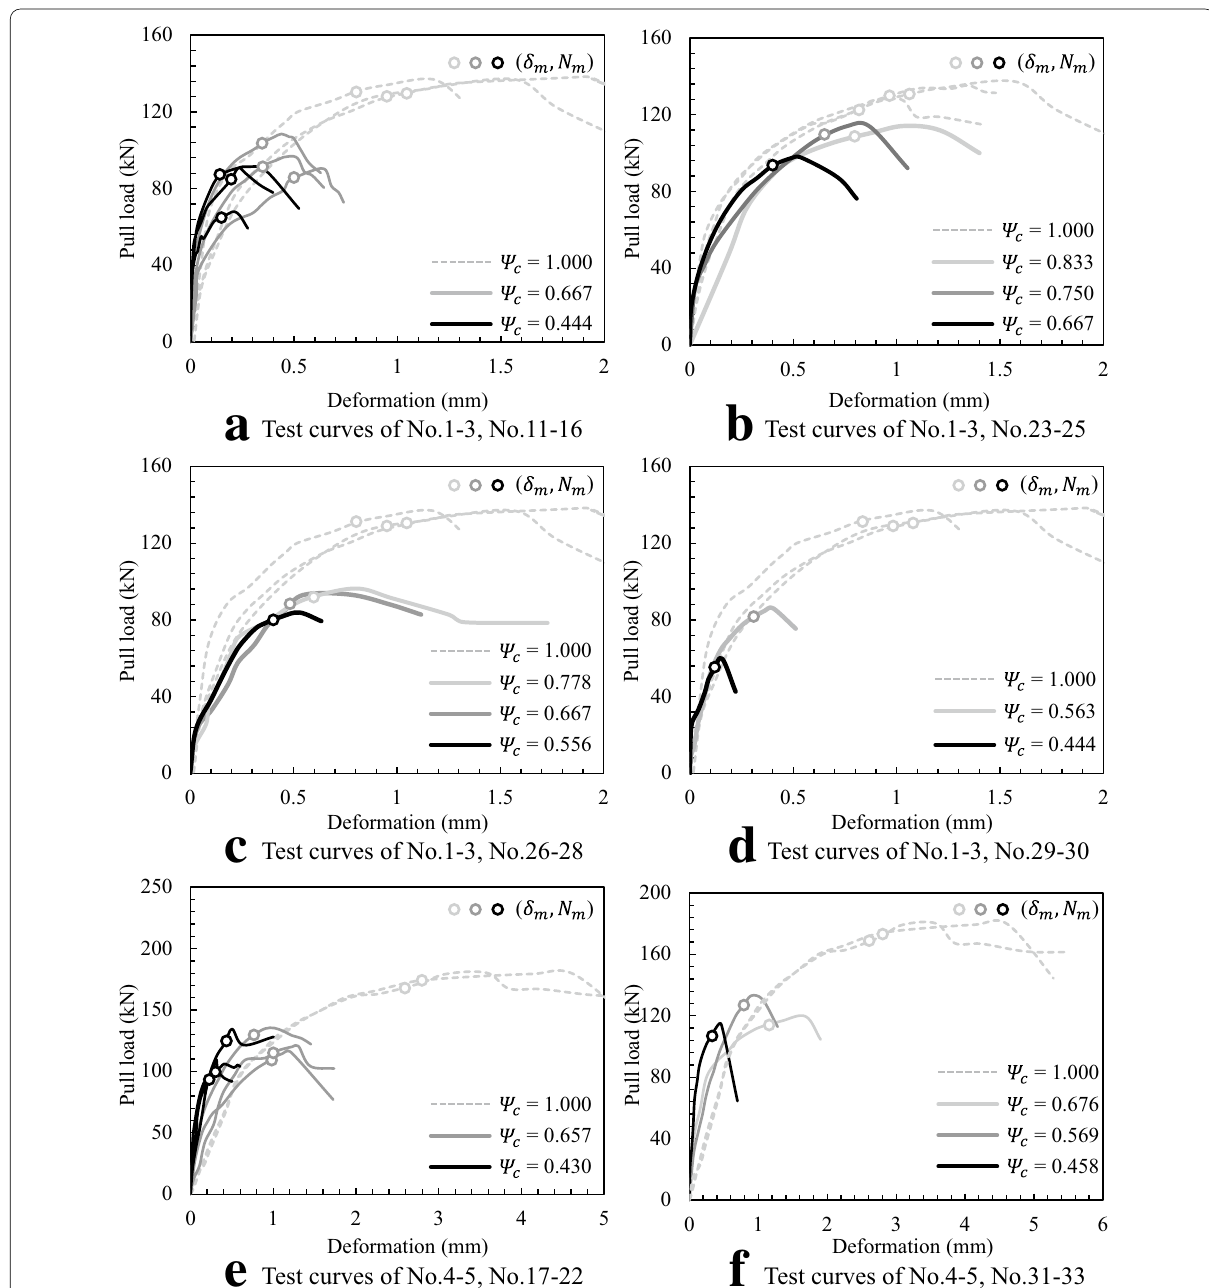
Fig. 12 Load–deformation curves of the anchorage concrete with different boundary